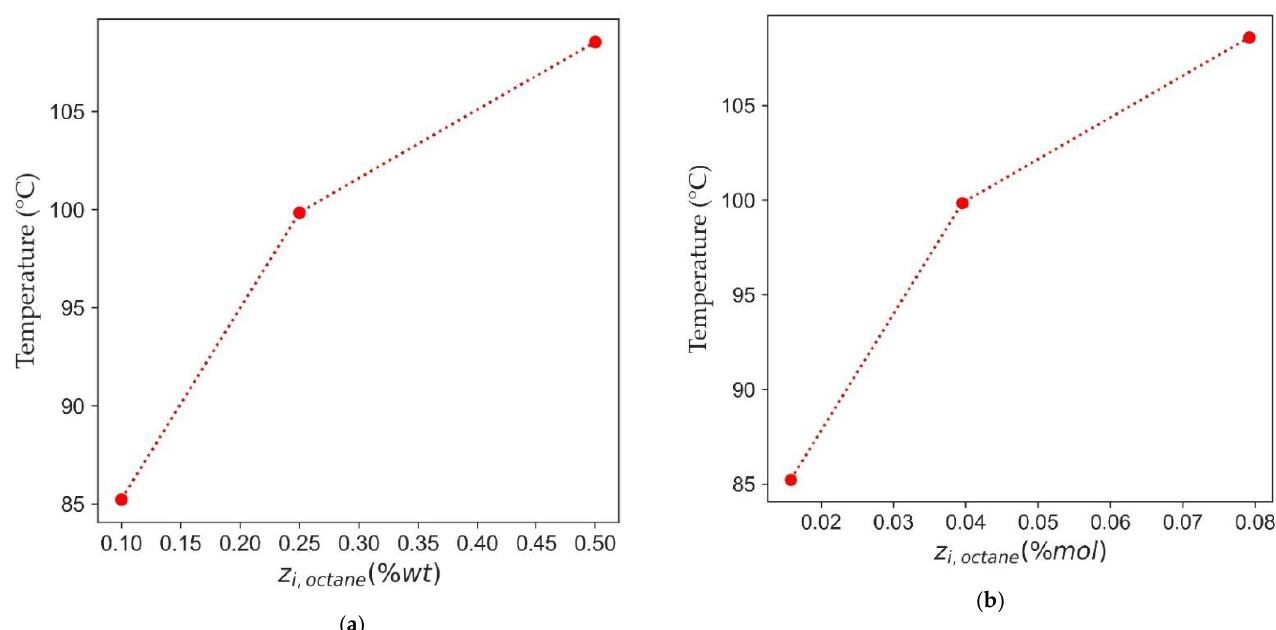
Figure 15. Temperature Change from the TPR to the Two Phase Region (highly diluted octane in water) ( a ) mass percentage, ( b ) mol percentage.